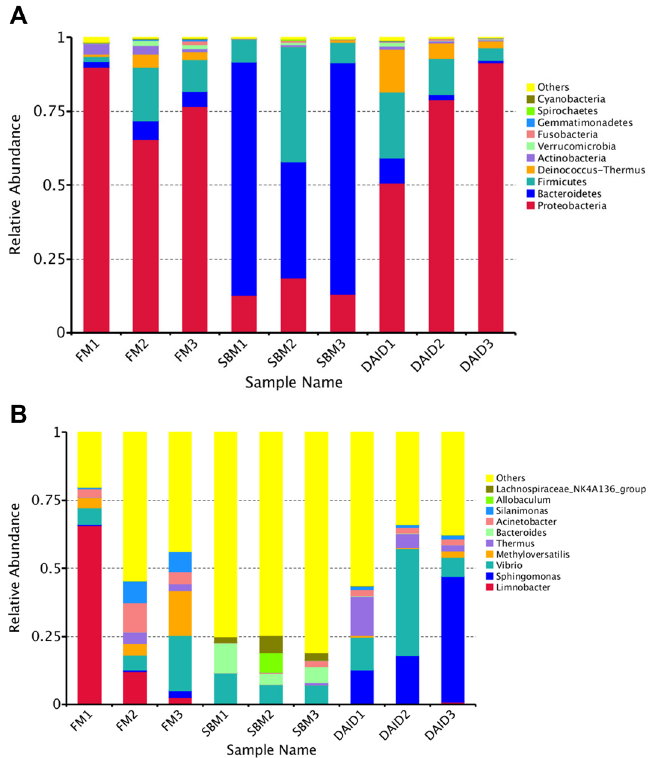
Figure 6. Top 10 most abundant (based on relative abundance) bacterial phyla ( A ) and genera ( B ). FM fish meal diet, SBM soybean meal diet, DAID 40 mg/kg daidzein included into SBM